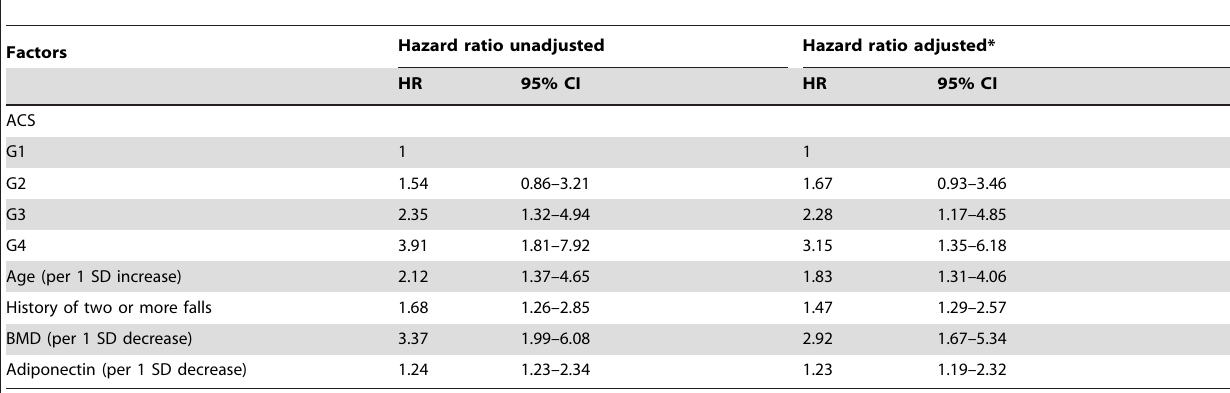
Table 3. Association between AC and vertebral fractures in Cox proportional hazard regression model.